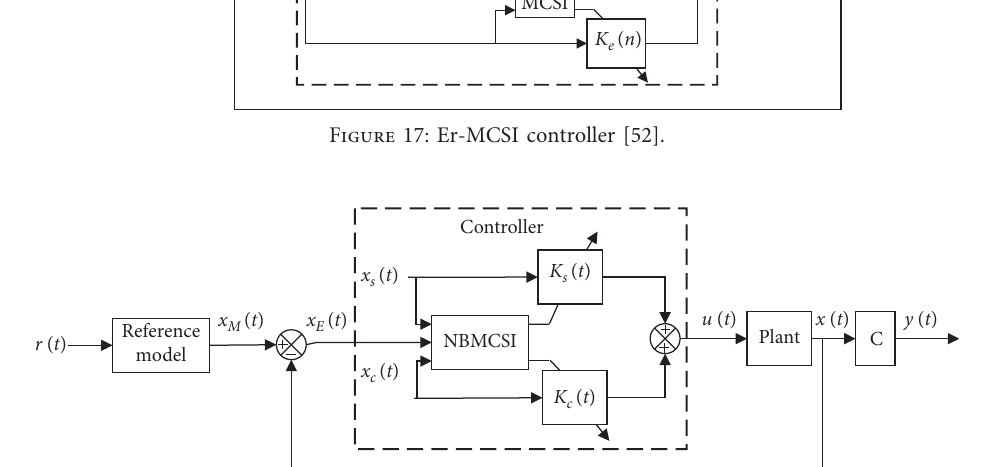
Figure 18: Block diagram of the NBMCS controller